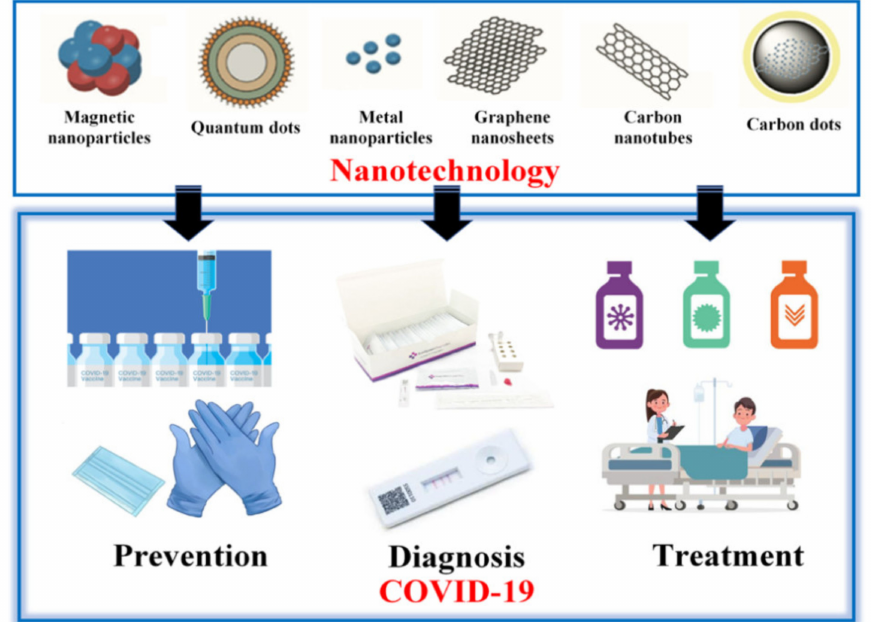
Figure 1. Applications of nanotechnology in COVID-19 prevention, diagnostics and